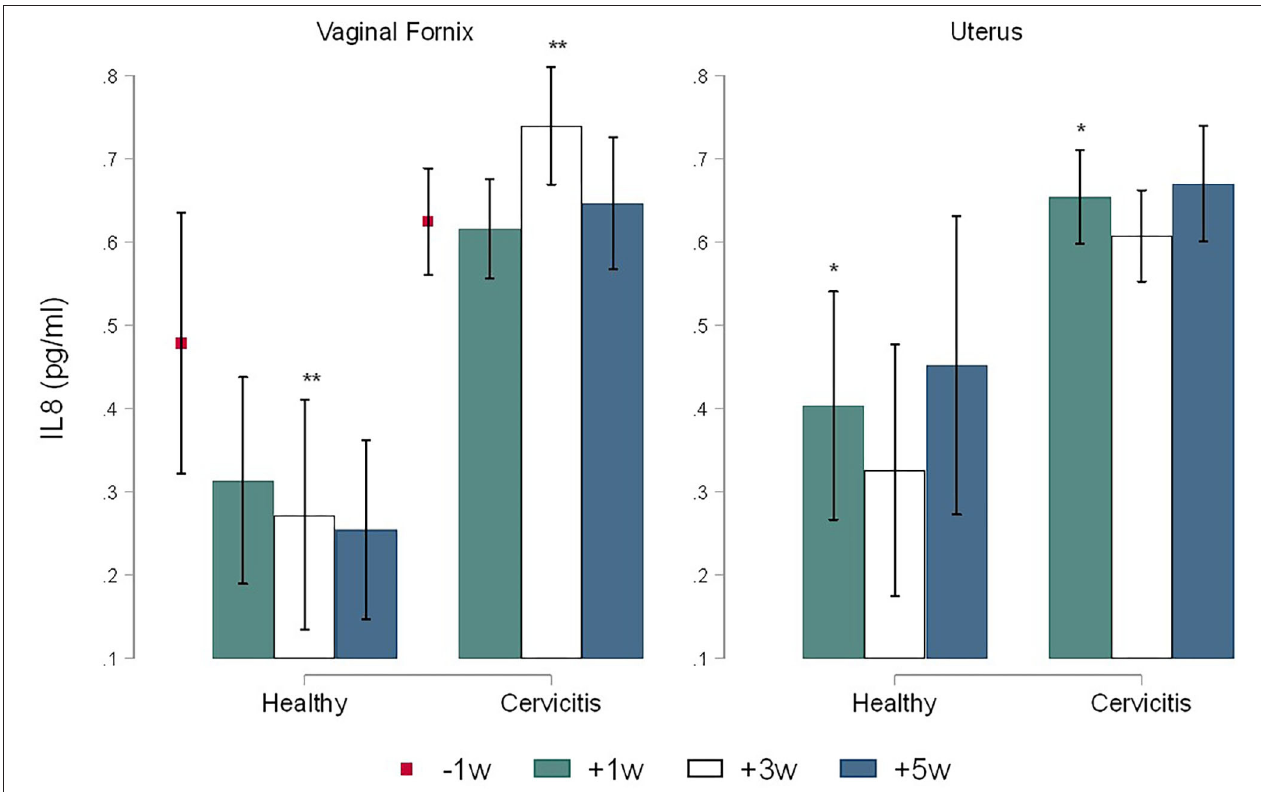
FIGURE 4 | Time-course variations (Mean ± SEM) in pre and post-partum concentrations of IL8 in the vaginal fornix and uterine mucus of cows ( n = 26) defined as clinical cervicitis cows ( n = 19) and healthy cows ( n = 7) from three dairy herds in Quebec in 2016. Time-course variations (weeks − 1w + 1w + 3w + 5w) of α 1-acid glycoprotein (pg/ml) concentrations (Mean ± SEM). An asterisk indicates a significant difference at p ≤ 0.05 (*) or p ≤ 0.01 (**) for the Mann-Whitney Test (Ha: clinical cervicitis cows 6= healthy cows).